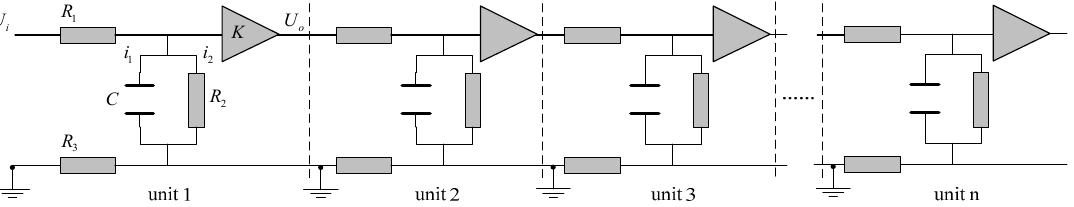
Figure 5. Cable model with a proportional amplification link artificially added.